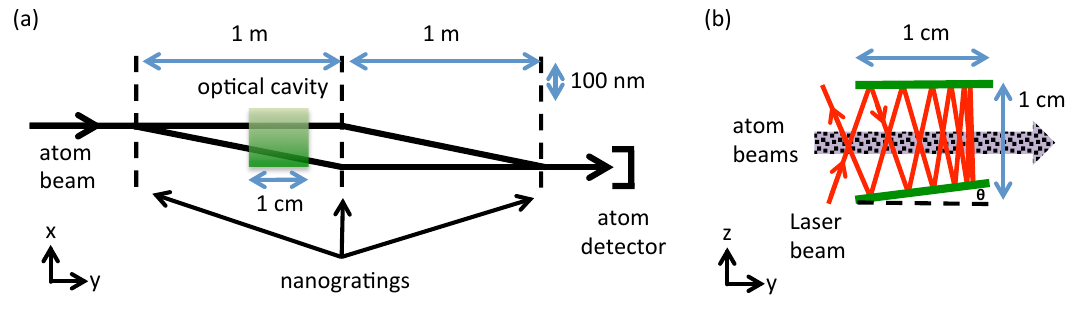
Figure 1. ( a ) Top-view schematic of a three-grating Mach–Zehnder atom interferometer passing through an optical cavity; ( b ) Side-view schematic of the plane–plane optical cavity aligned so atoms interact with multiple passes of the laser beam. Both atom beam paths shown in ( a ) are represented by one thick line and pass through the cavity in ( b ). The atom beam paths are each 30 µ m thick and have a 10 µ m separation between them. The mirror angle deviation from parallel ( θ ) is exaggerated to show how the laser beam folds back at different